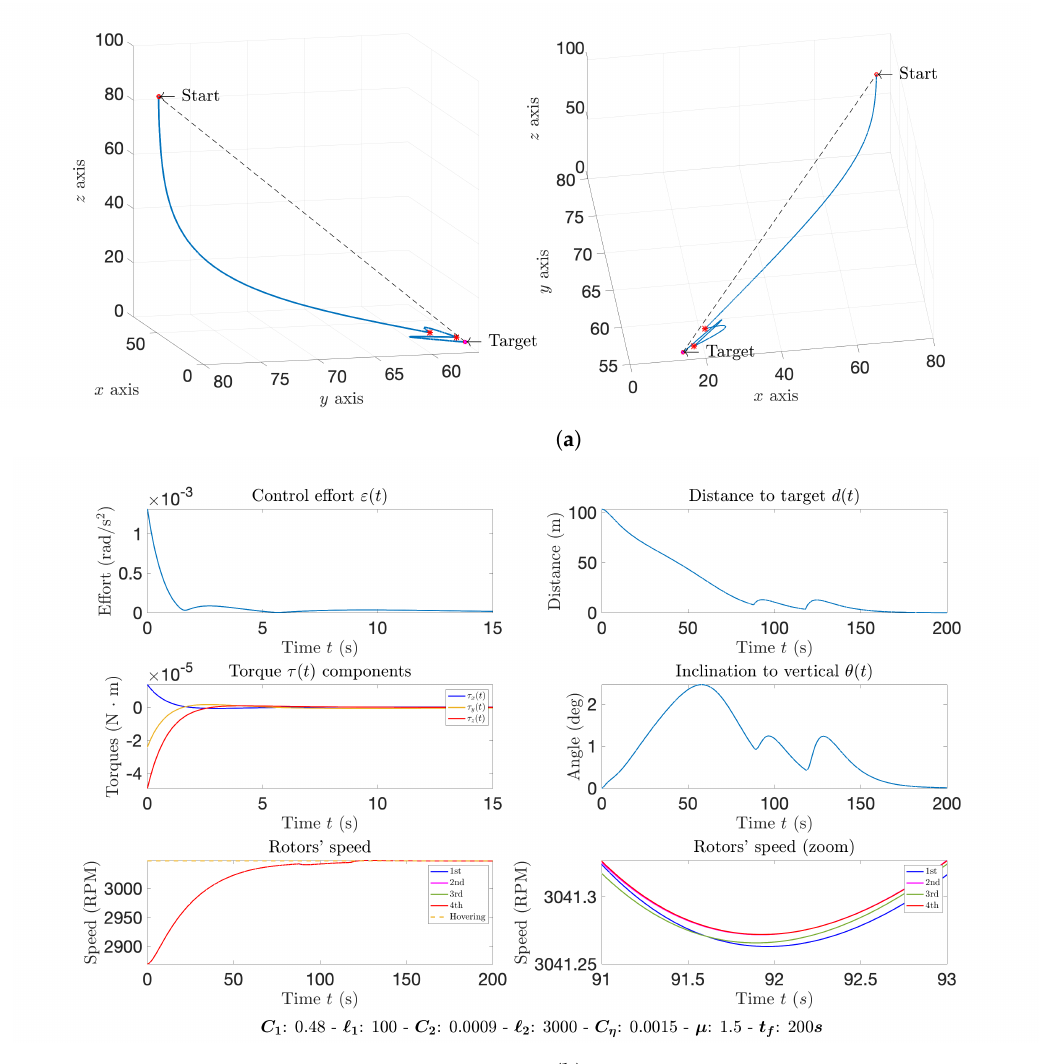
Figure 11. Experiment: Two impulsive forces. The red asterisks on the quadcopter trajectory represent the impact points. ( a ) Target approaching trajectory; ( b ) Control